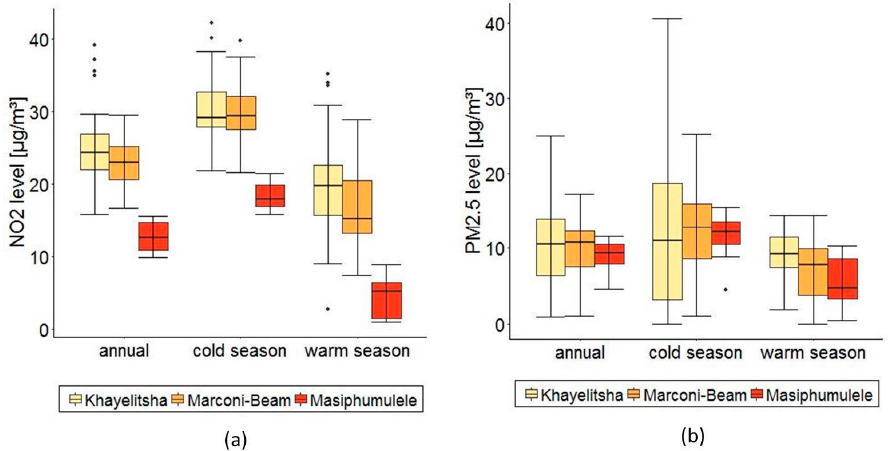
Figure 2. ( a ) Distribution of NO 2 seasonal means in the three study areas, including median distribution, interquartile range (IQR) and whiskers (1.5 IQR); ( b ) Distribution of PM 2.5 seasonal means in the three study areas, including median distribution, interquartile range (IQR) and whiskers (1.5 IQR).